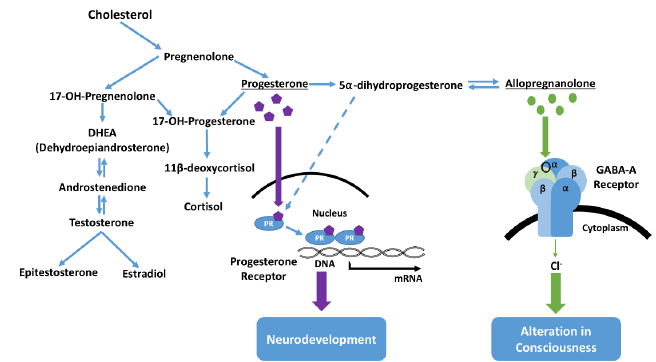
Figure 5. Synthesis and pathways of neurosteroids in the brain [27]. Neurosteroids can have potent effects on both neurodevelopment and consciousness [12]. Progesterone and its related derivatives have been reported to affect gene transcription important for neurodevelopment. Additionally, progesterone and deoxycorticosterone serve as precursors for the endogenous neurosteroid allopregnanolone, which acts on the GABA receptor to rapidly alter consciousness. Levels of neurosteroids in the blood, central nervous system, and spinal fluid are distinct, and may be influenced by levels of precursor steroids shown here. Elevated blood levels of progesterone, pregnenolone, androstenedione, dehydroepiandrosterone, and epitestosterone have been reported in foals with NMS, and are possibly associated with behavioral and conscious state alterations [12].